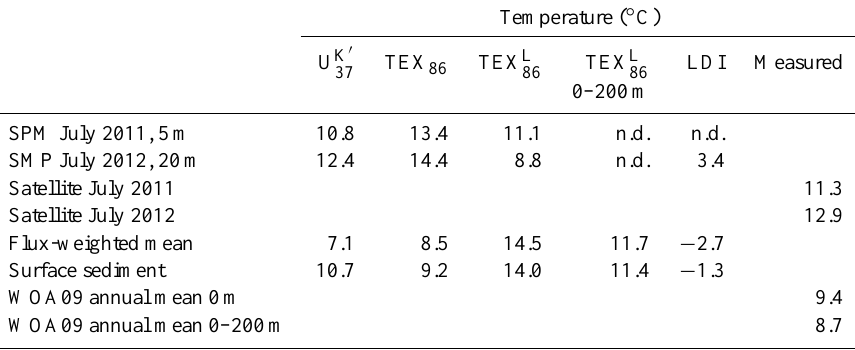
Table 3. Proxy-derived temperatures at St 1 in the northern part of the Iceland Basin in sedimenting particles and surface sediment and measured temperature data from satellite observations (AVHRR, NOAA) and from the climate database WOA09 (Locarnini et al.,